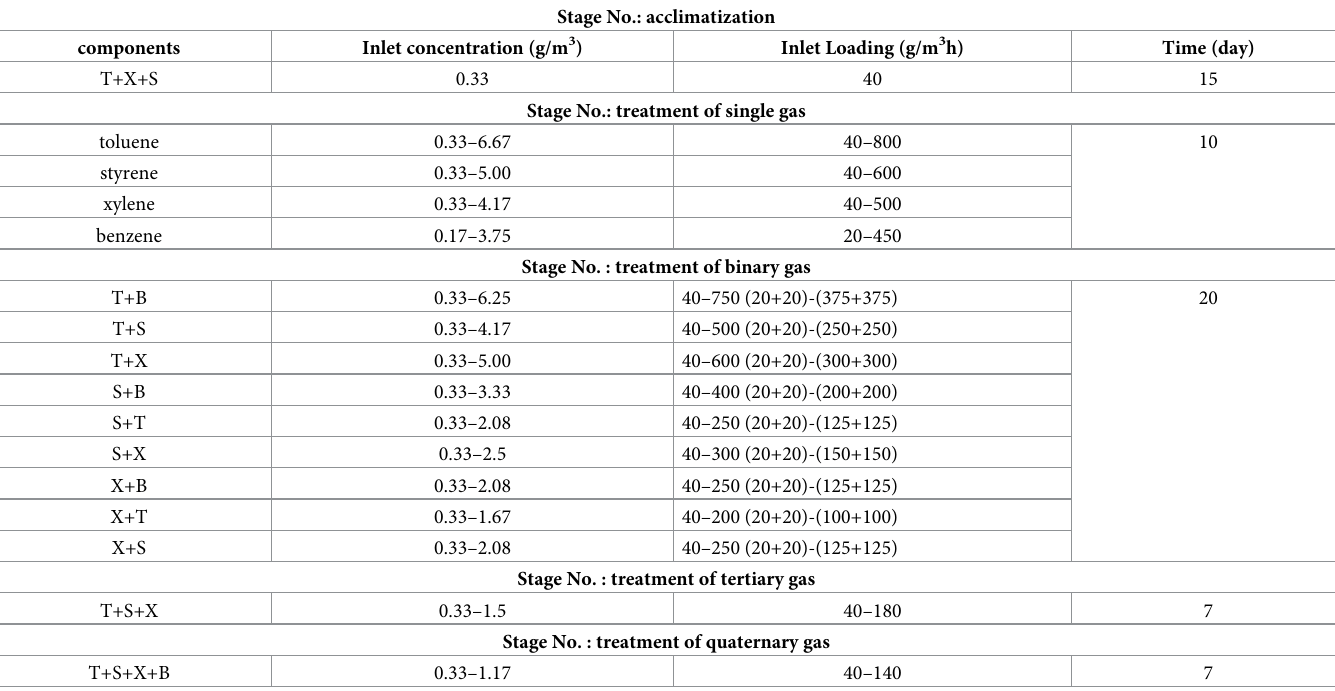
Table 1. Experimental procedures and conditions of